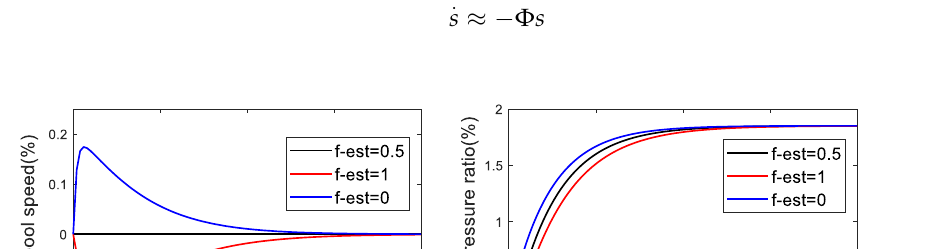
Figure 10. FTC result in different fault reconstruction (FC) situations. ( a ) controlled variables ( b ) control variables.